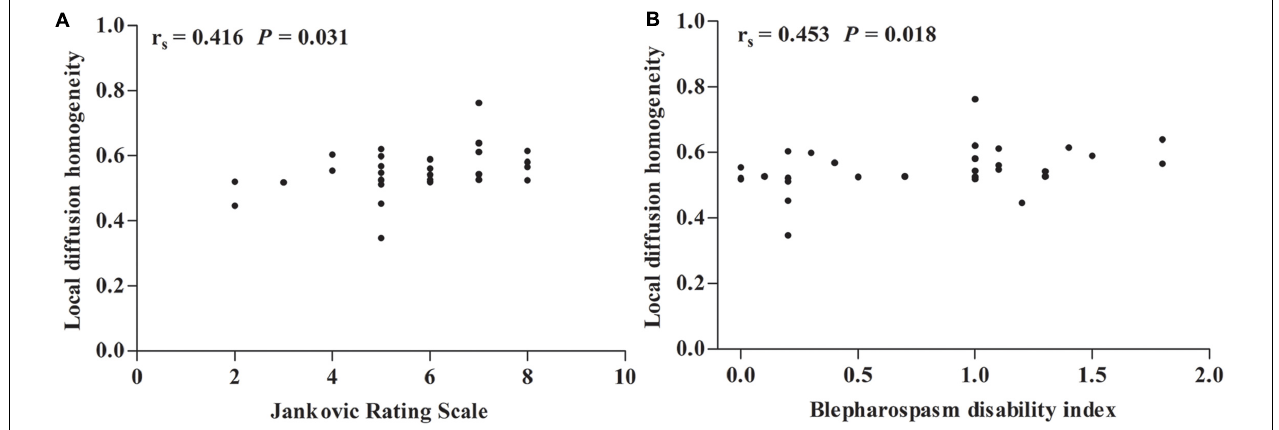
FIGURE 2 | Spearman correlation maps. (A,B) Spearman correlation plots for local diffusion homogeneity in the region of interest (ROI) A ( y -axis), as well as Jankovic rating scale and blepharospasm disability index ( x -axis). ROI A represents left superior longitudinal fasciculus, splenium of corpus callosum, posterior corona radiata, posterior thalamic radiation (include optic radiation), body of corpus callosum, and superior corona radiata. r s = Spearman correlation